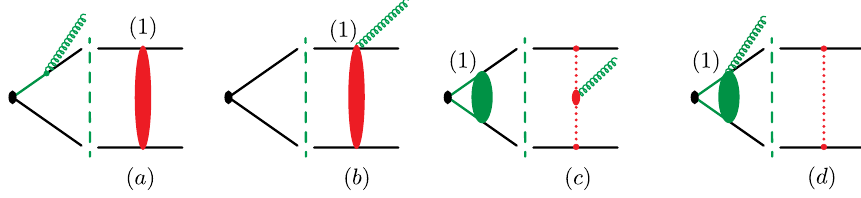
Figure 6 . Diagrams needed for extension of AMFS result to two-loops. Additional diagrams not shown include one-loop corrections to the n - s forward scattering and soft emission diagrams involving 3 Wilson